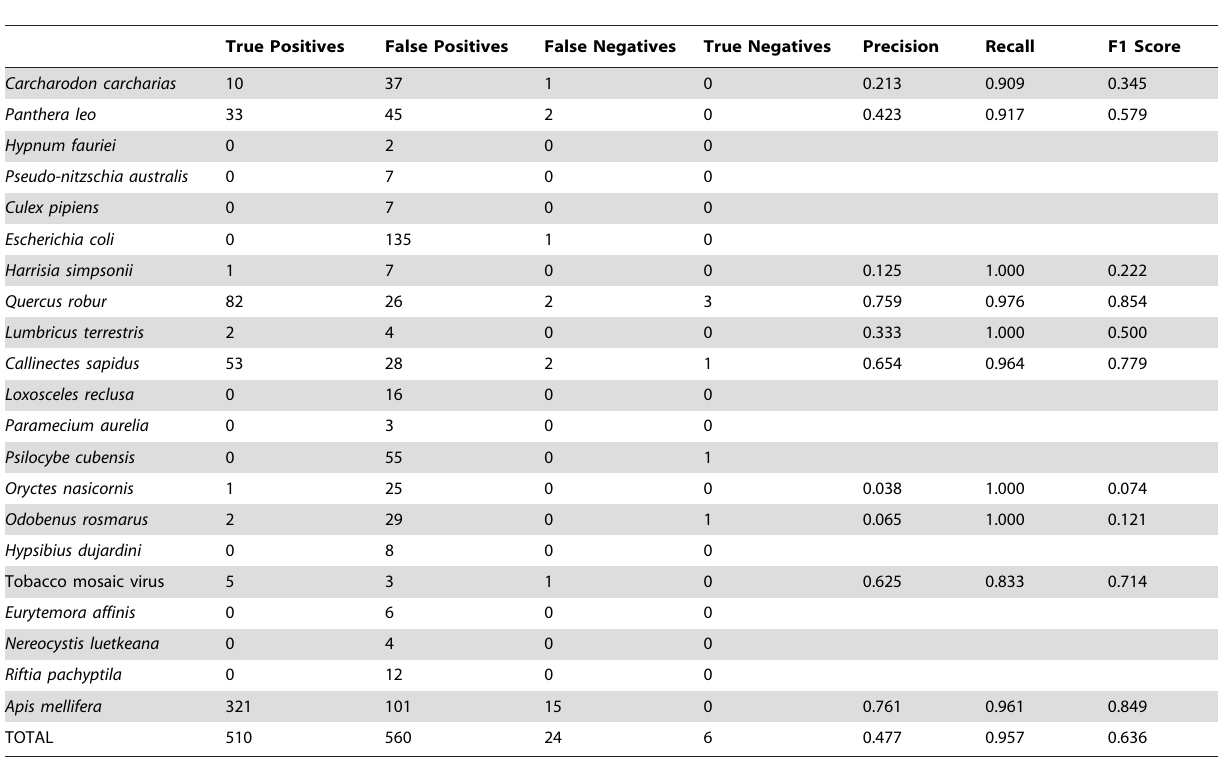
Table 4. Performance of GNRD without Associations Workflow.